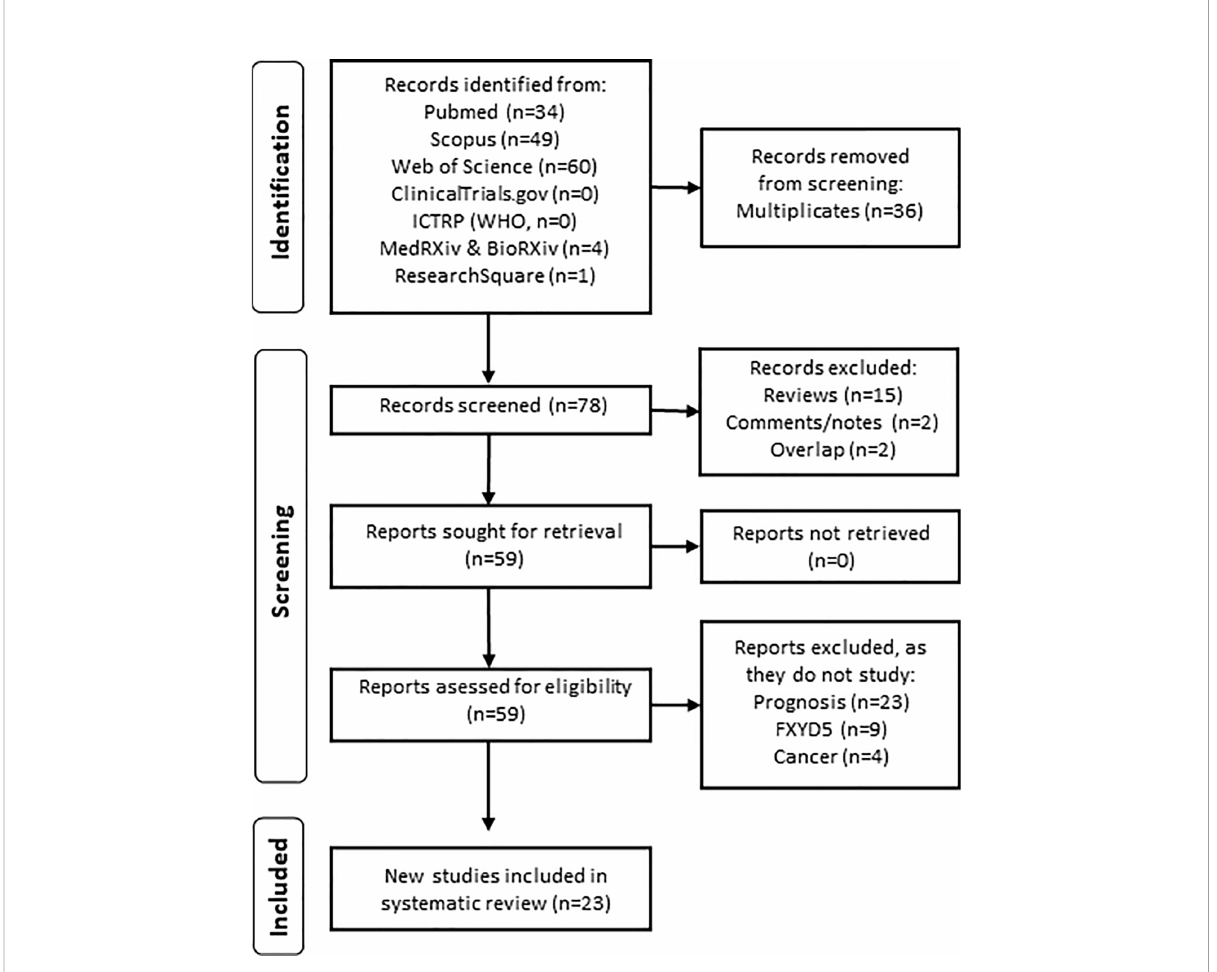
FIGURE 1 Systematic literature search depicted as fl